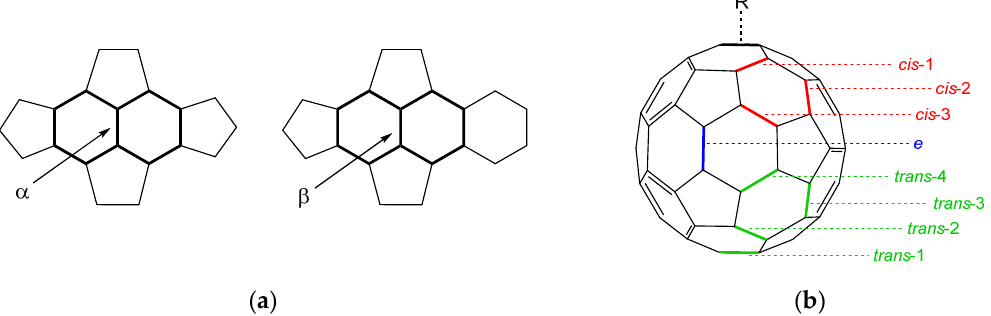
Figure 1. Bond nomenclature in fullerenes: ( a ) The two most curved and reactive [6,6] bonds in fullerenes; adapted from Thilgen et al. [9]; ( b ) Possible isomers for C 60 bisadducts depending on the positions of the two groups; adapted from Ref. [1], nomenclature as suggested by Hirsch et al. [10].